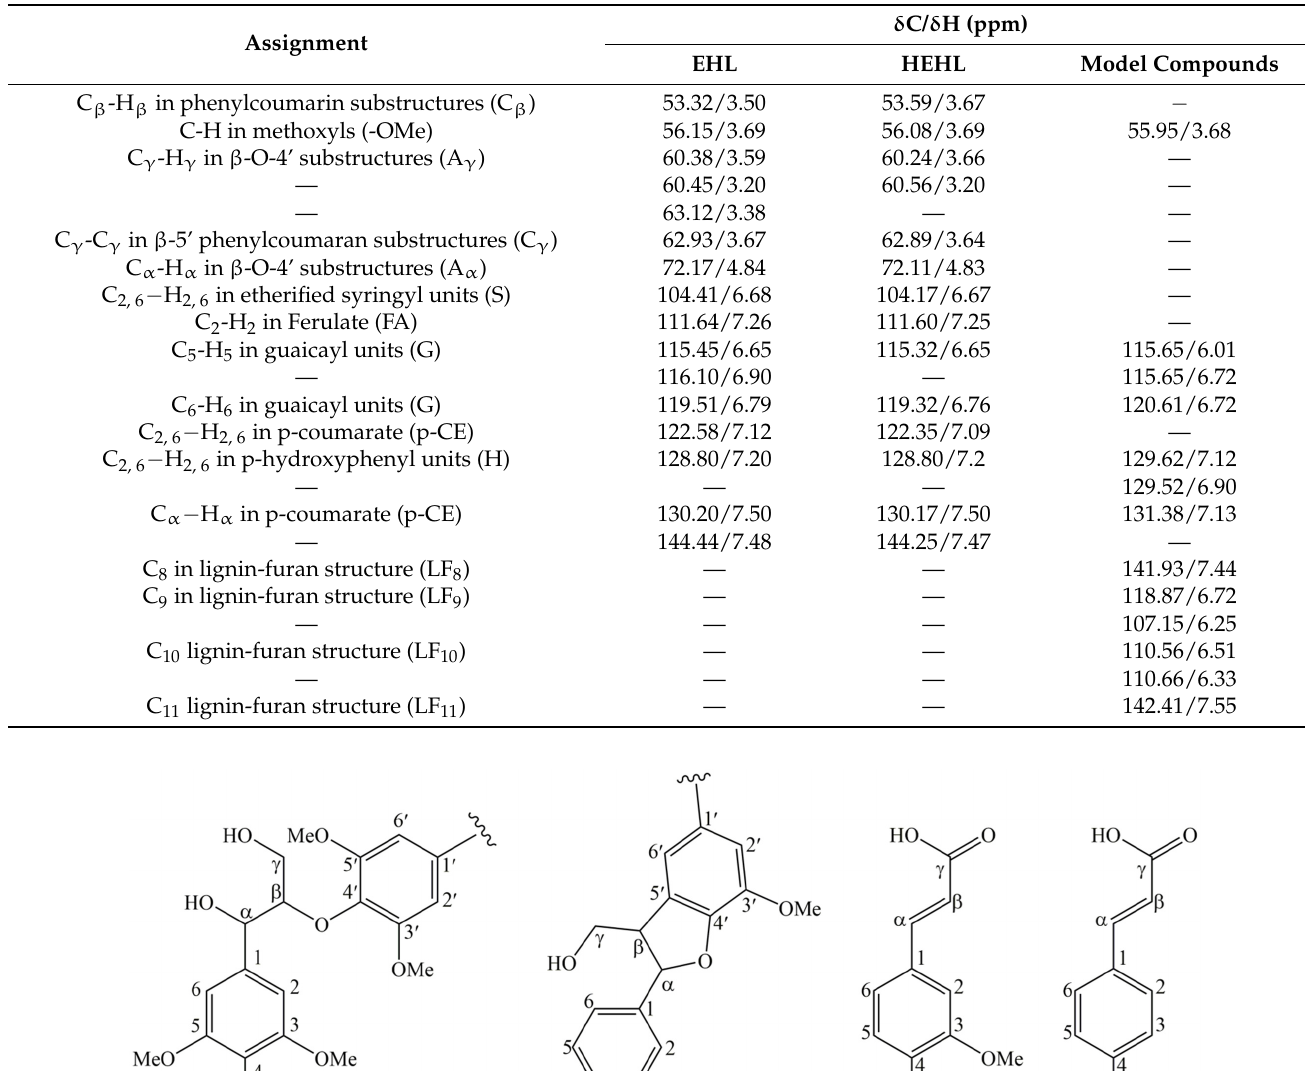
Table 8. Assignment of 13C-1H cross-signals in the HSQC spectra of EHL, HEHL, and model compounds. Assignment